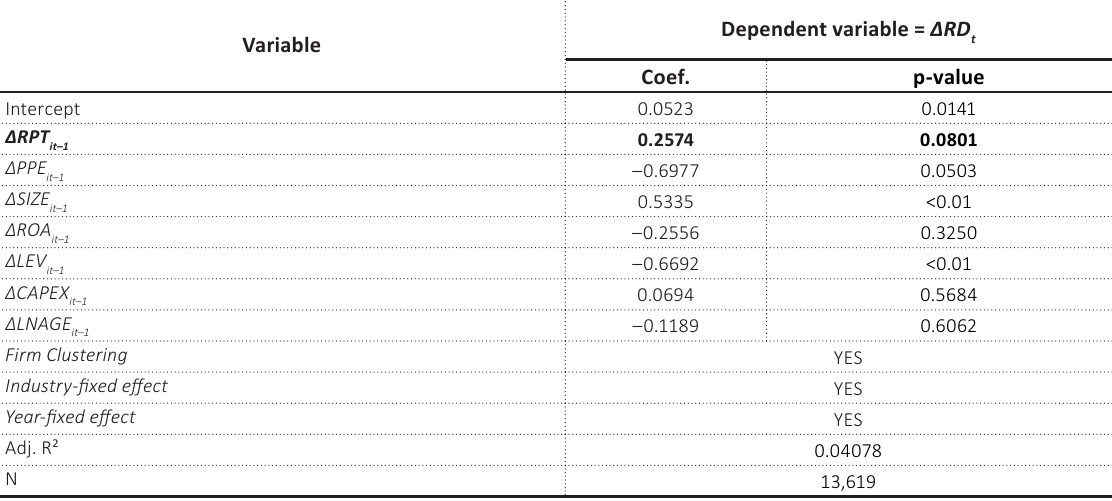
Table 7. Robustness test: Changes in RPTs and changes in the firm’s R&D investments Panel A: Change analysis by using total